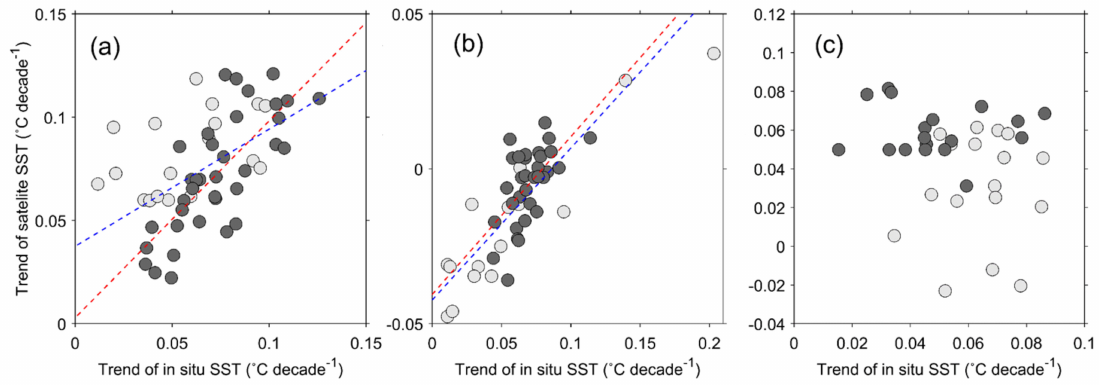
Figure 11. Comparison of in situ temperature trends ( ◦ C decade − 1 ) and satellite SST trends in ( a ) the East / Japan Sea, ( b ) the Yellow Sea, and ( c ) the southern coastal regions, where black circles represent trends with 95% confidence levels and light (dark) grey dots represent the points close to (far from) the coast, and the blue (red) dashed line represents its least squares linear